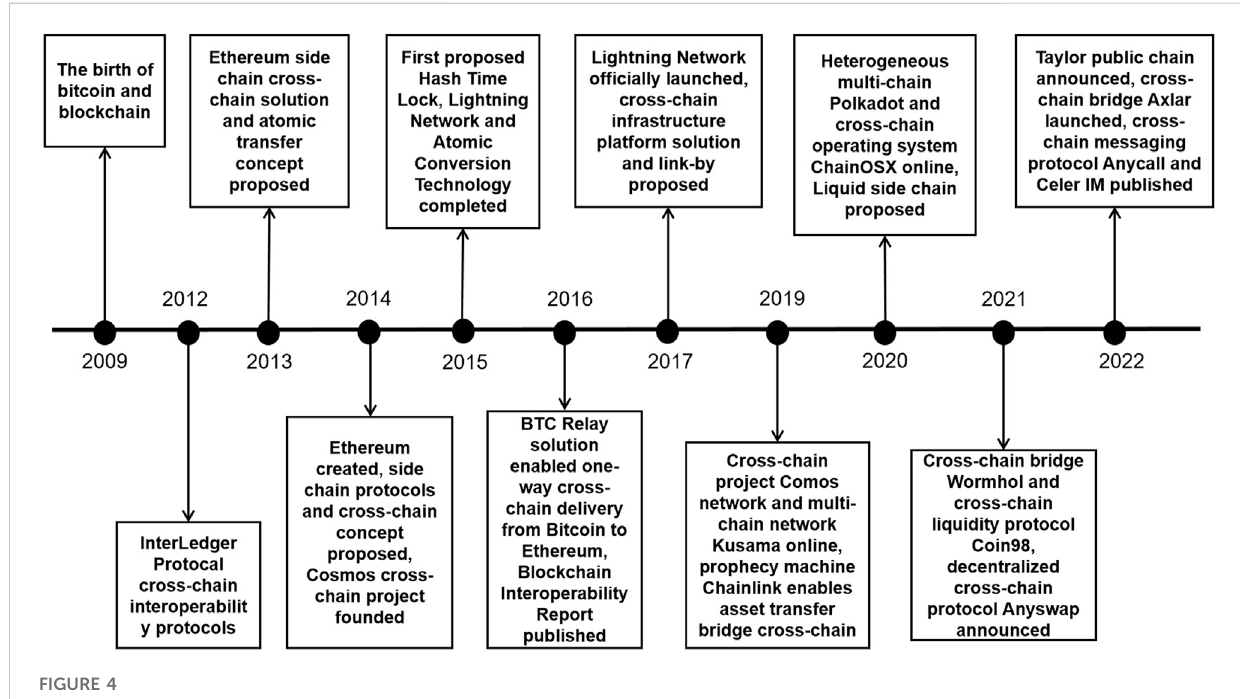
FIGURE 4 The development process of cross-chain